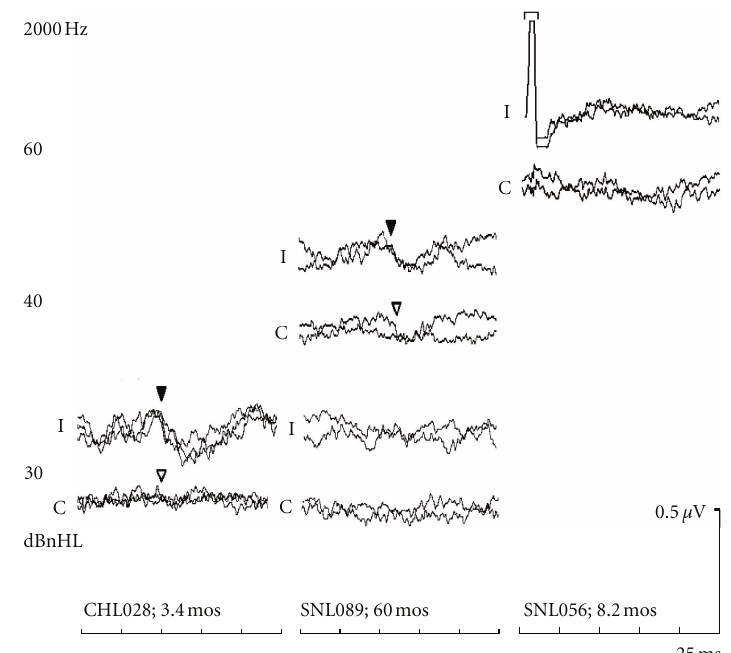
Figure 3: Left panel: ABRs to 30dBnHL BC 2000 Hz tones recorded from an infant with conductive hearing loss at the time of ABR testing, who had normal hearing at behavioural followup. Middle Panel: “Elevated” 2000 Hz BC-ABR results (threshold = 40dBnHL) from a child who showed a moderate sensorineural hearing loss at behavioural followup. Right panel: “Elevated” 2000 Hz BC-ABR results (threshold > 60dBnHL) from an infant who showed profound sensorineural hearing loss behaviourally. STM indicates the region of uncancelled stimulus